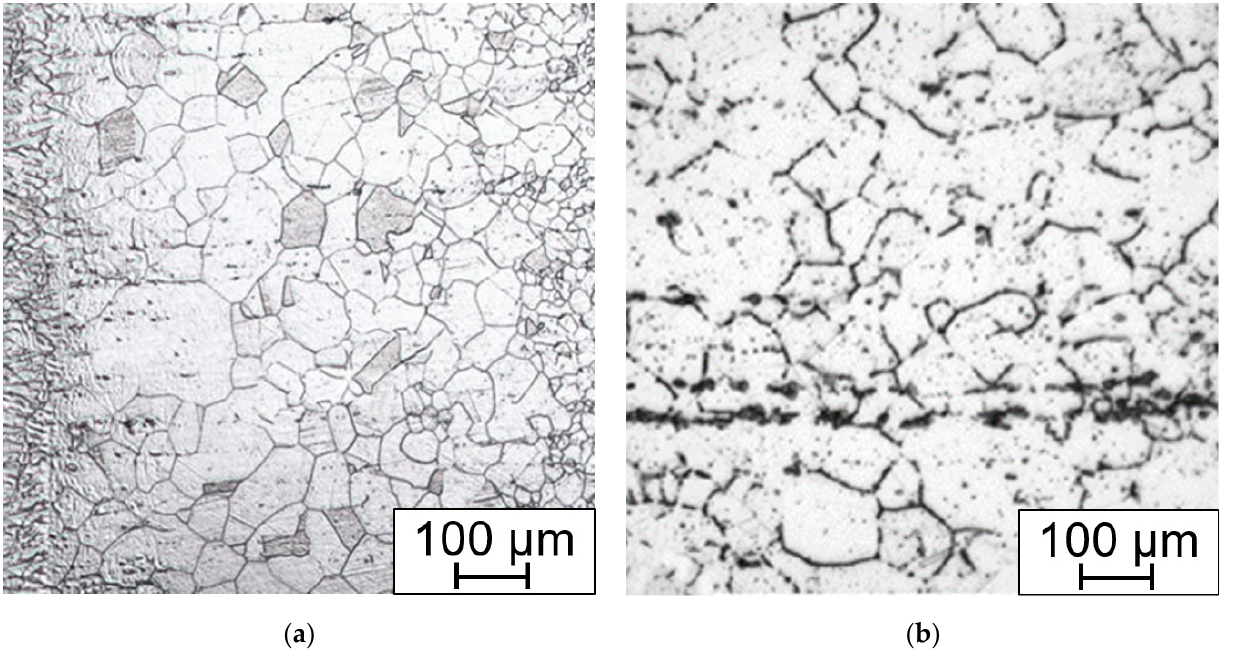
Figure 16. Weld without annealing, ( a ) HAZ with fusion line on the left; ( b ) HAZ, precipitation on the GB, rows of the primary carbides Electrolytically etched in 10% aq. acetic acid (5 V DC, 10 s).